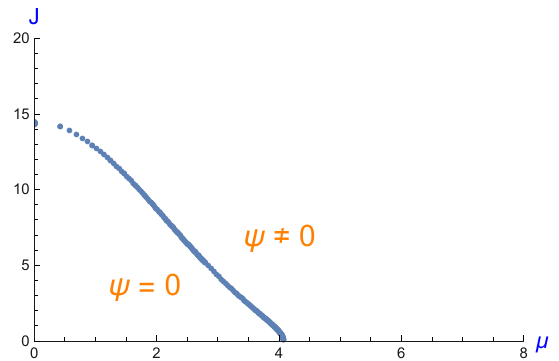
Figure 4. Phase Plot: source of the (cid:12)eld vs. chemical potential, at the point where the oper- ator expectation value of (cid:12)eld (cid:30) is just turned on ( hO i (cid:20) 0 : 002). The value of the lagrangian ( (cid:30) ) parameters are respectively m 2 = (cid:0) 2 = m 2 ; (cid:11) 1 = 1 = (cid:11) 2 ; (cid:12) = 0 : 6, (cid:21) = 1 2